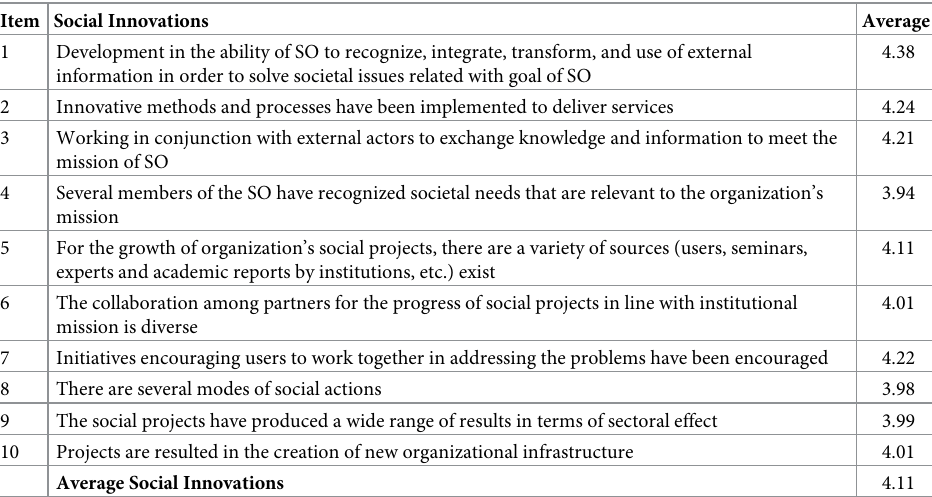
Table 1. Average percentage in the items of social